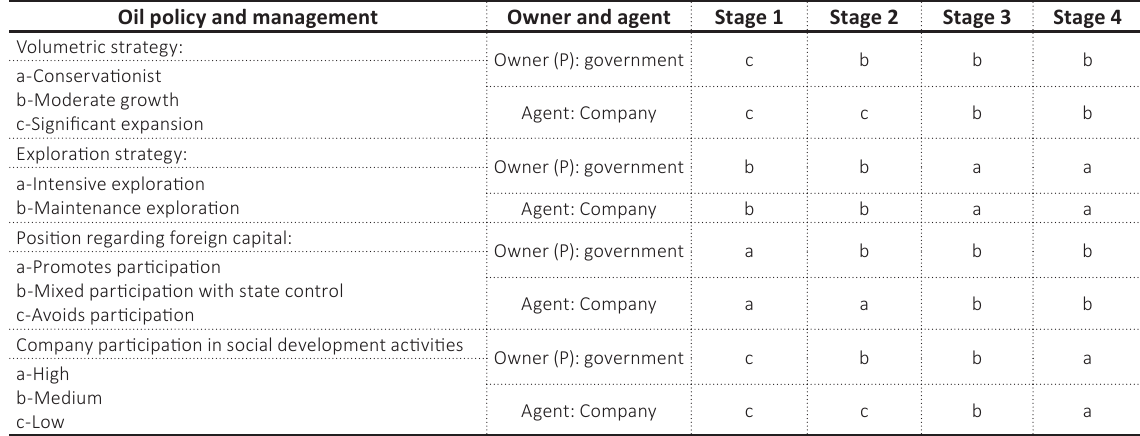
Table 1. Position regarding the oil policy between the owner and the agent by stages